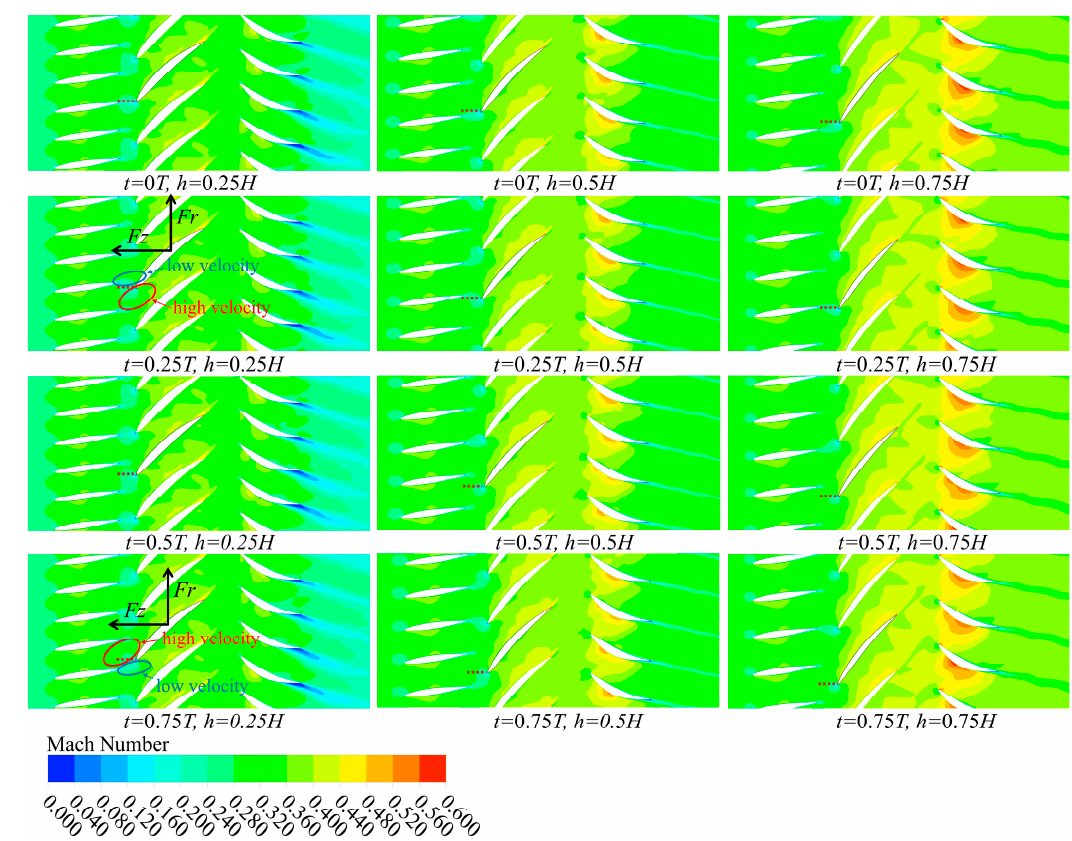
Figure 12. Mach number distribution of the 𝑎 = 0 mm model under design conditions.